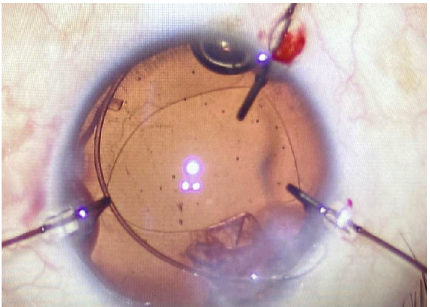
Figure 3: After the completion of phacoemulsi fi cation, a tension ring was placed in the bag, and the dislocated part of the bag was supported by pressing against it.